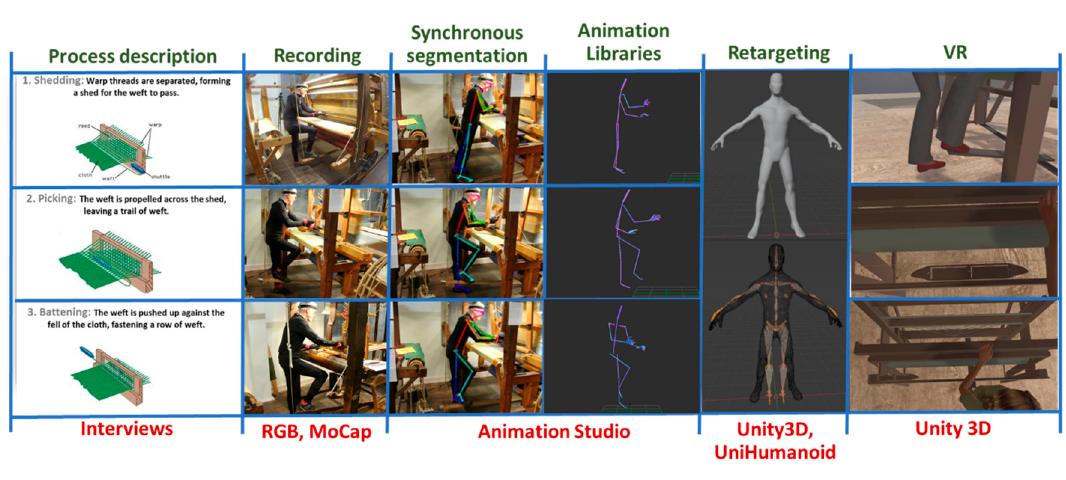
Figure 1. Overview of the proposed approach.